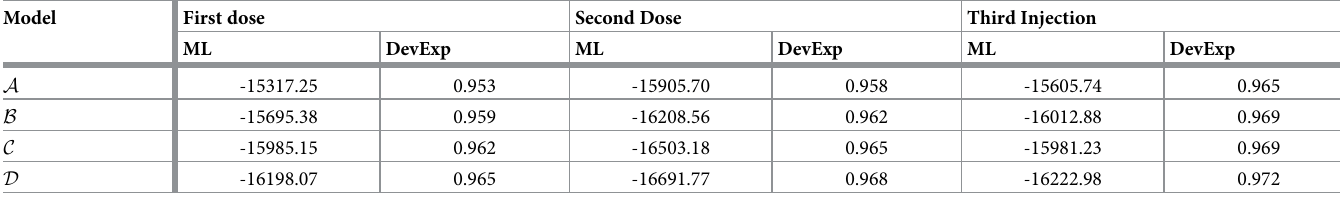
For each model and vaccination, the table gives the ML value of the fitted model and the proportion of deviance explained (see S1 Appendix). Lower values of ML correspond to models with a better fit, according to the criterion used here to fit the models. Higher values of DevExp correspond to models which come closer to the best possible fit using a different criterion (the